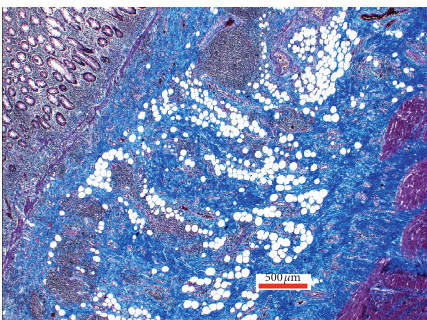
Figure 1: Example of fibrosis stained blue in Masson Trichrome special